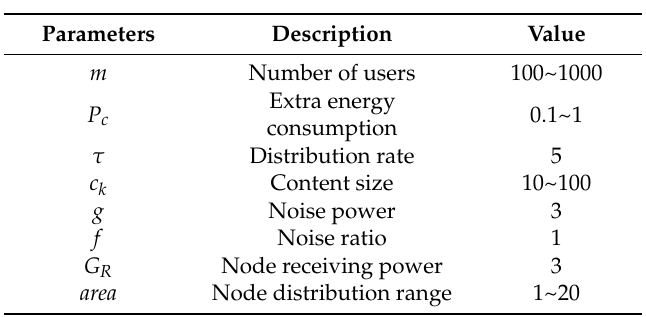
Table 1. Simulation